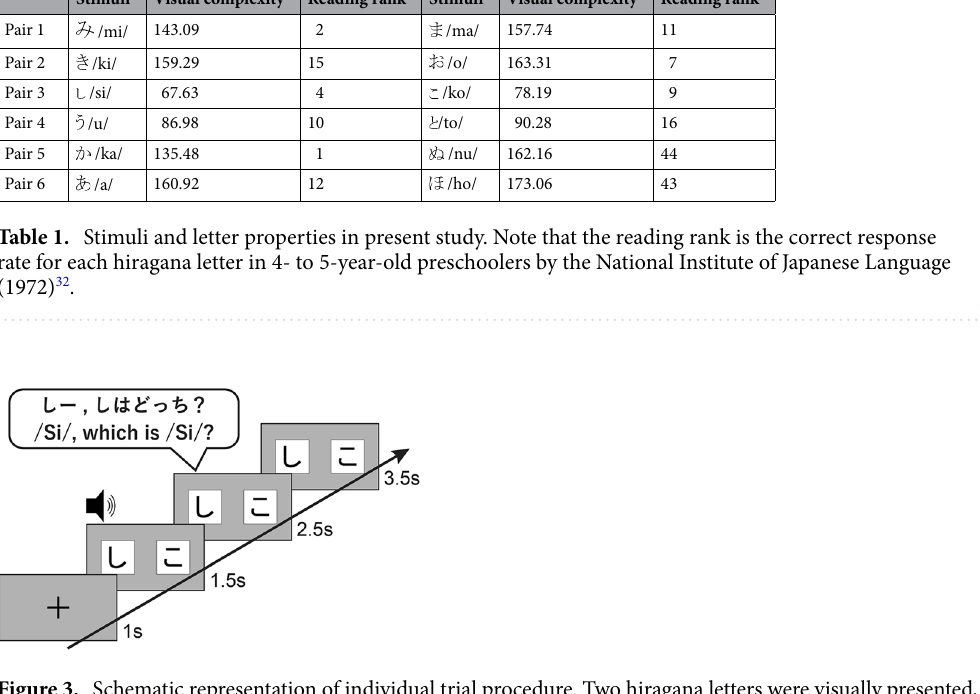
Figure 3. Schematic representation of individual trial procedure. Two hiragana letters were visually presented, and target hiragana sounds were auditorily